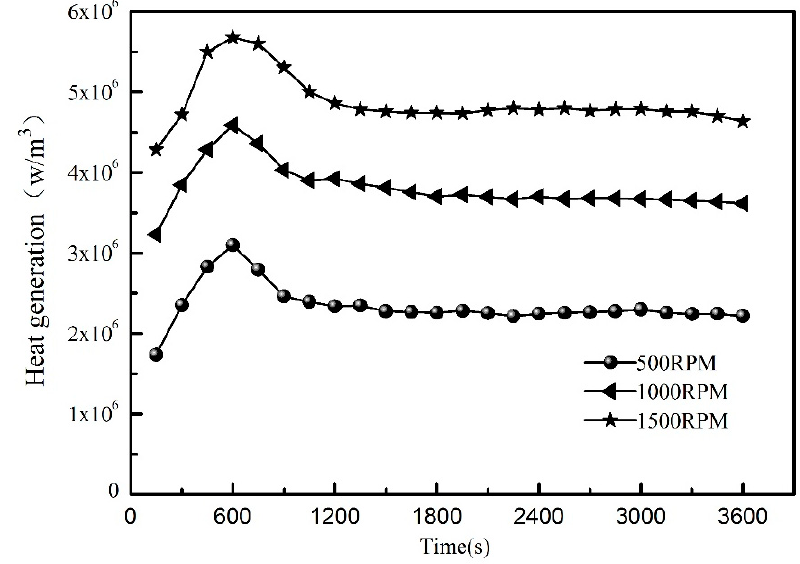
Figure 12. Estimated heat sources of front bearing at different speed.